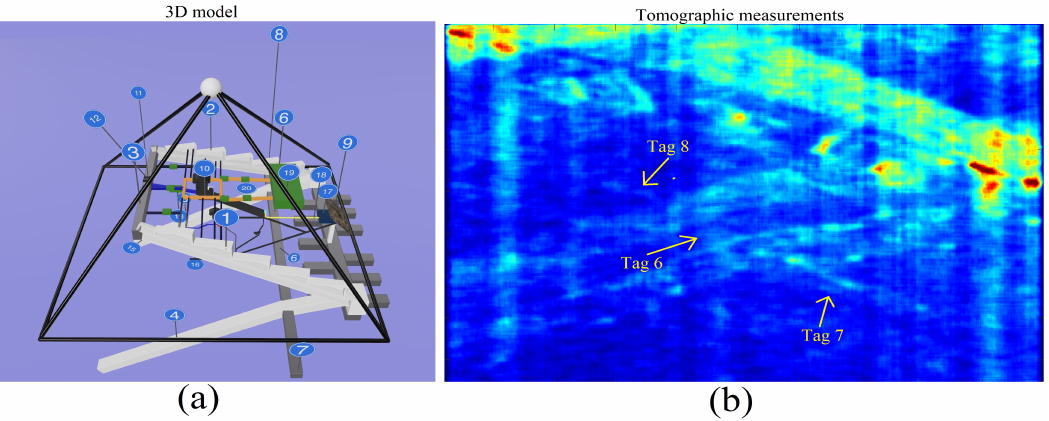
Figure 44. Tags association from tomography to 3D model. ( a ): Three-dimensional (3D) model of Khnum-Khufu (Top-East-side orientation). ( b ): Tomographic reconstruction